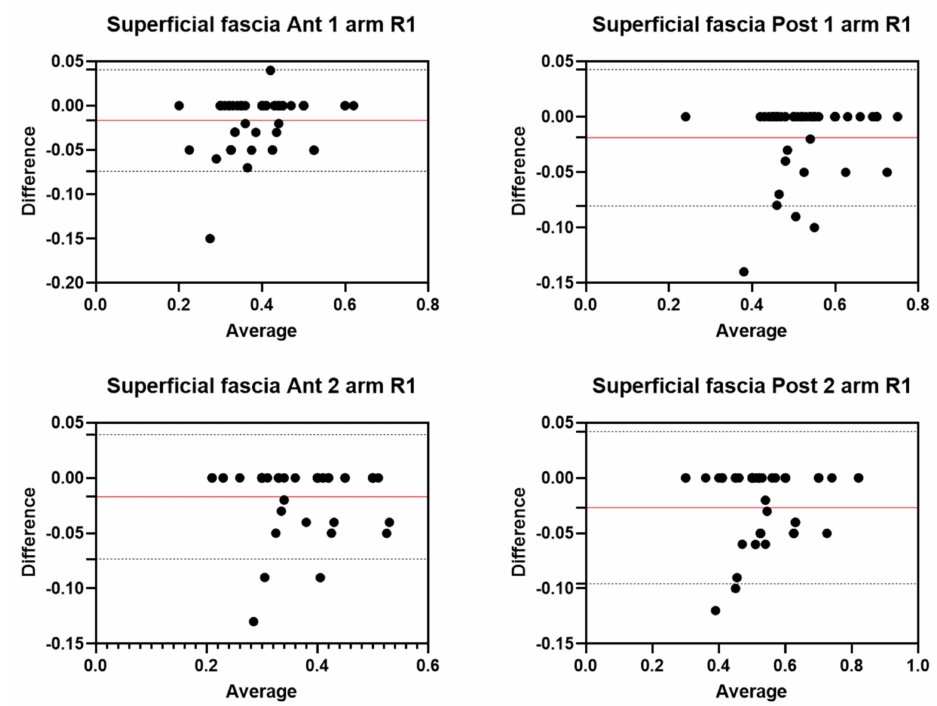
Figure 7. Bland–Altman plot comparing two sessions of Rater 1 (R1) measuring the US thickness of the superficial fascia of the arm for the different levels. Red line = bias or mean difference; dashed lines: 95% limits of agreement (LoAs).